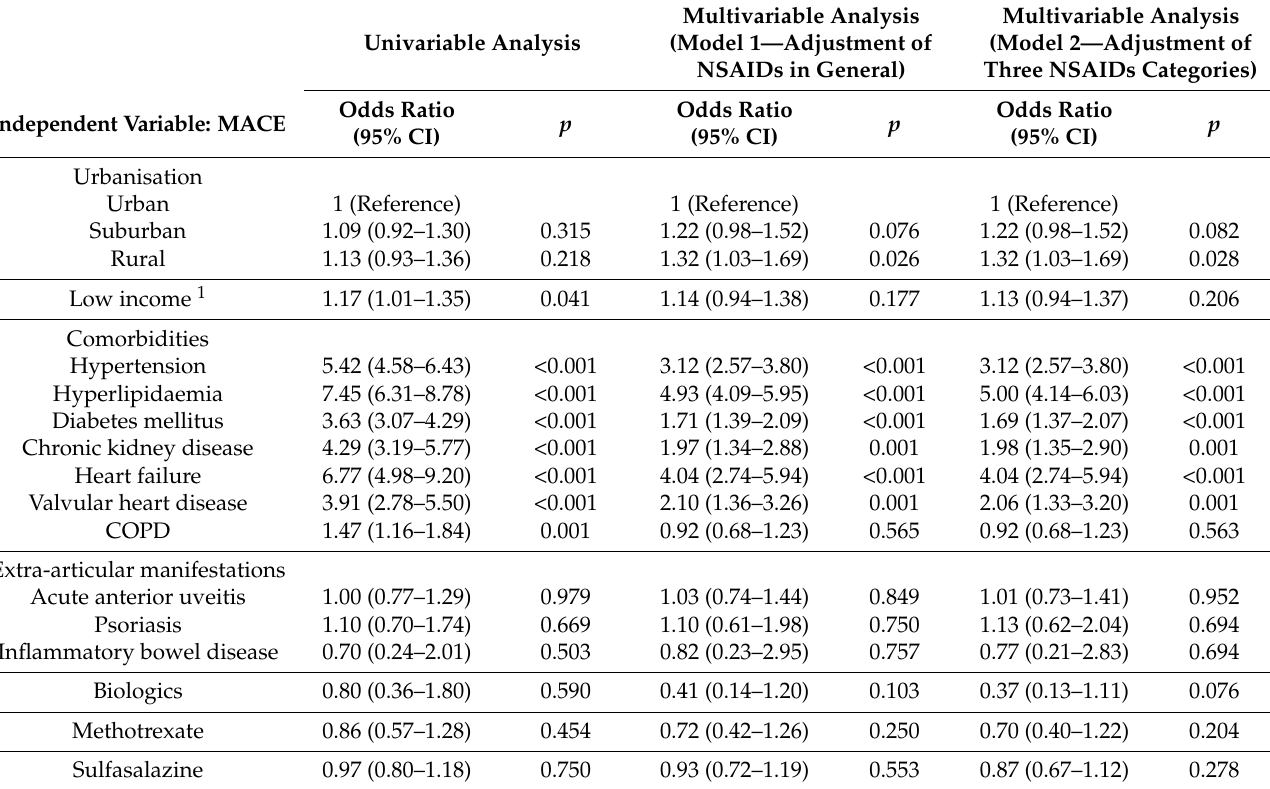
Table 2. Factors associated with MACE in patients with ankylosing